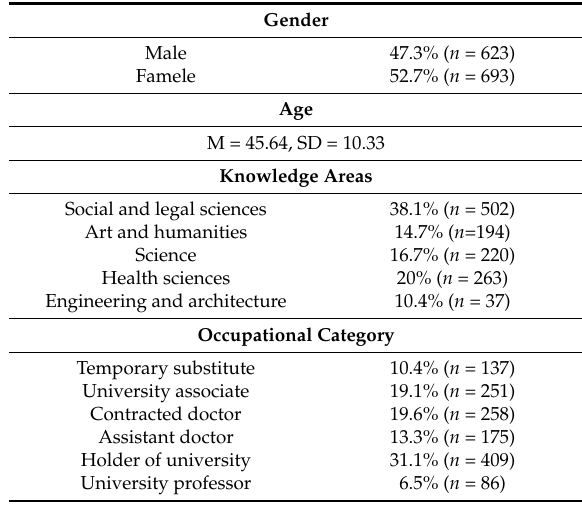
Table 1. Demographic